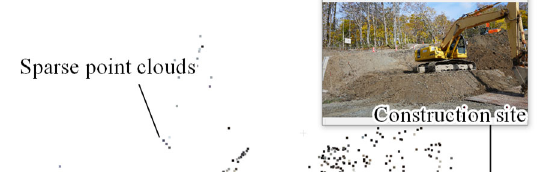
Figure 10. The additional image and the added camera pose.